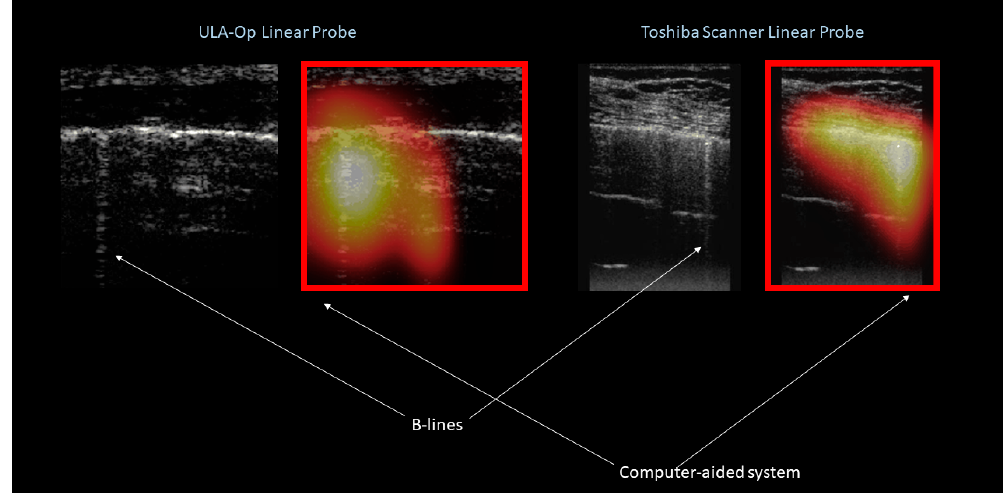
Figure 4. Ultrasound images obtained during patients investigation using an open research platform (on the left) and clinical scanner (on the right). The result in terms of detection and localization as obtained by the computer aided system in also shown.